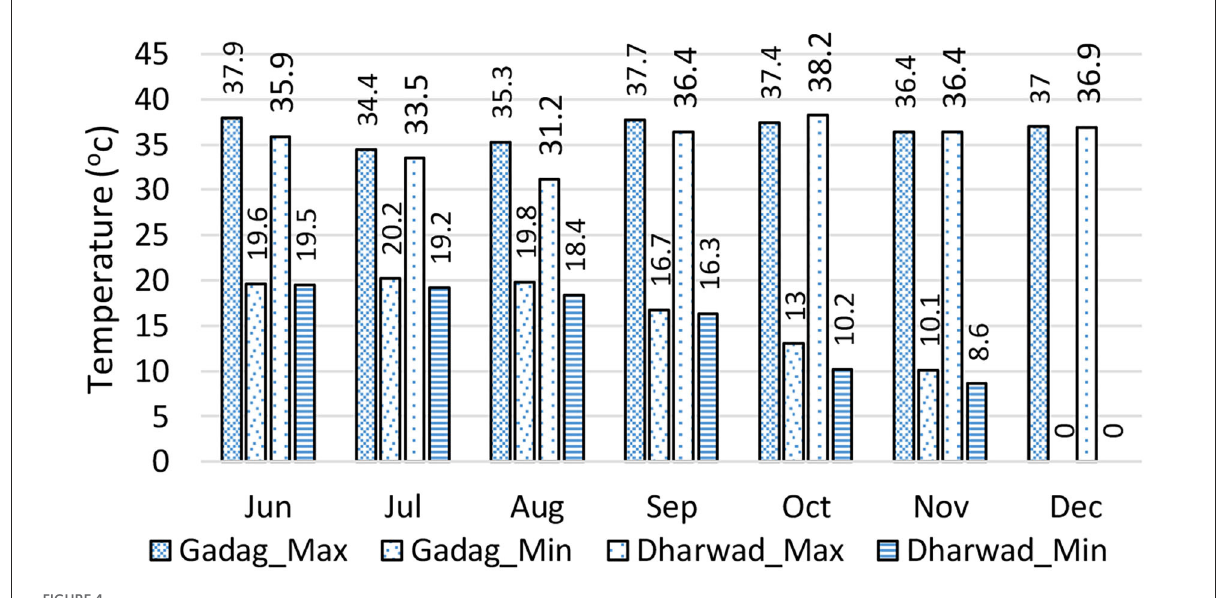
FIGURE4 Temperature range in study locations in